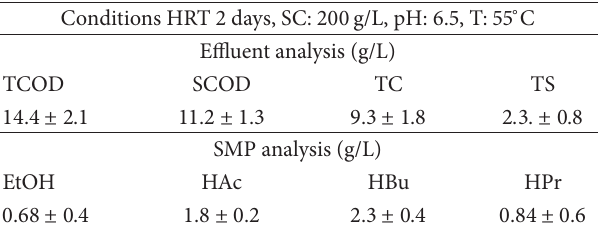
Table 3: Effluent and SMP analysis at steady